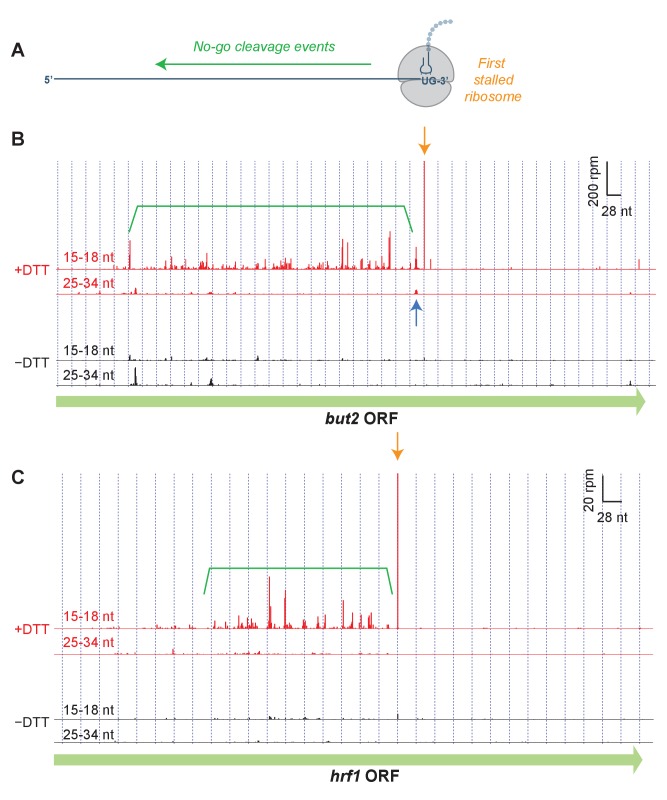
Short read alignments to individual example genes reveal no-go decay.(A) Model for how Ire1 cleavage leads to ribosome stalling when the 3’ UG is positioned in the A site. This stalled ribosome triggers upstream cleavage of the mRNA (no-go decay, green arrow). These upstream cleavages are expected to, in turn, stall additional ribosomes. (B) Example of (3’ end assignment) ribosome profiling data from the dom34Δ/ski2Δ strain on the gene but2. The data show an initial Ire1-mediated cleavage at a UG/C site (orange arrow). Upstream cleavage events (no-go decay) are evident as peaks in the short-footprint data (ribosomes stalled on truncated mRNA ends) in the presence of DTT (green bracket). The peak in the long-read data (blue arrow) suggests a ‘disome’ structure forms when an upstream ribosome runs into the ribosome stalled on the 3’ terminal UG. (C) Same as (B) but for the gene hrf1.